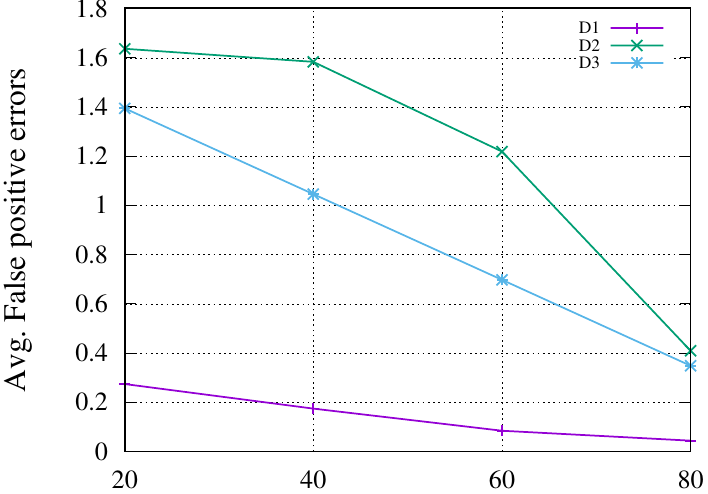
Figure 12. False-positive match analysis at different fault points.